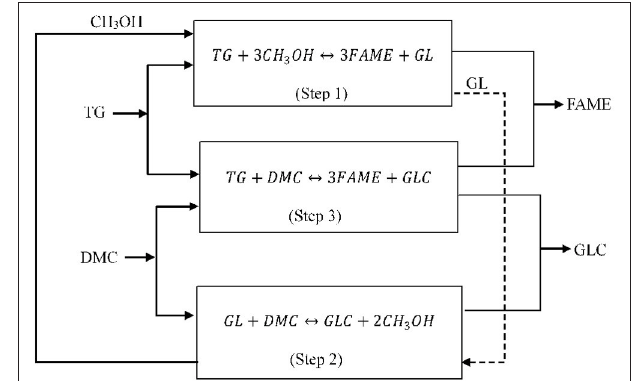
methanol and in situ reactive coupling of the by-product glycerol with DMC to form